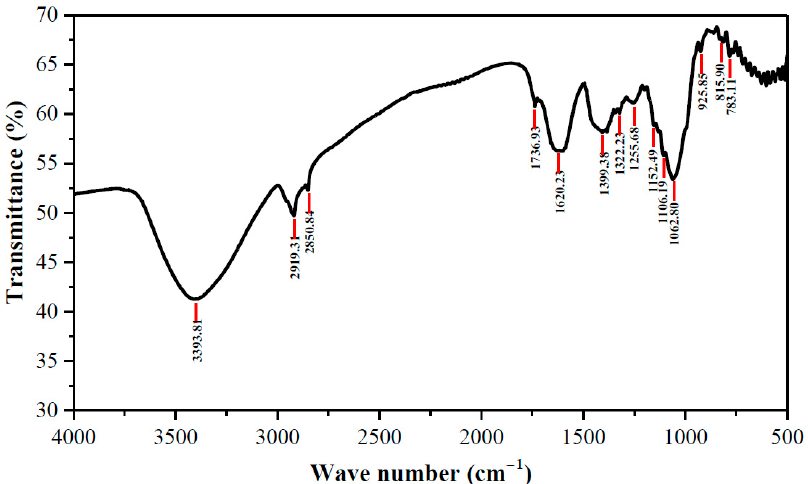
Figure 3. FTIR spectra of banana peel; Conditions: 25 ◦ C, banana peel: KBr = 1:100, number of scans: Figure 3 30, resolution: 2 cm − 1 .